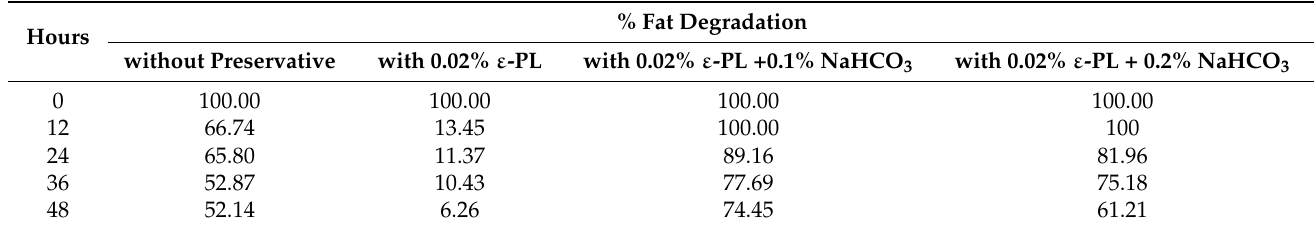
Table 7. Effect of ε -PL and sodium bicarbonate as the preservative on fat